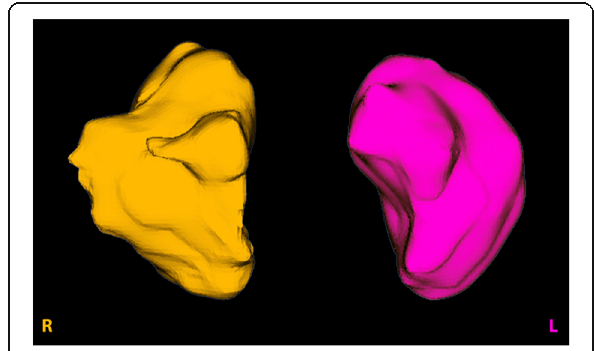
Fig. 3 3D view of osseus sinus volumes. Surface area (cm 2 ) and volume (cm 3 ) were calculated by the software